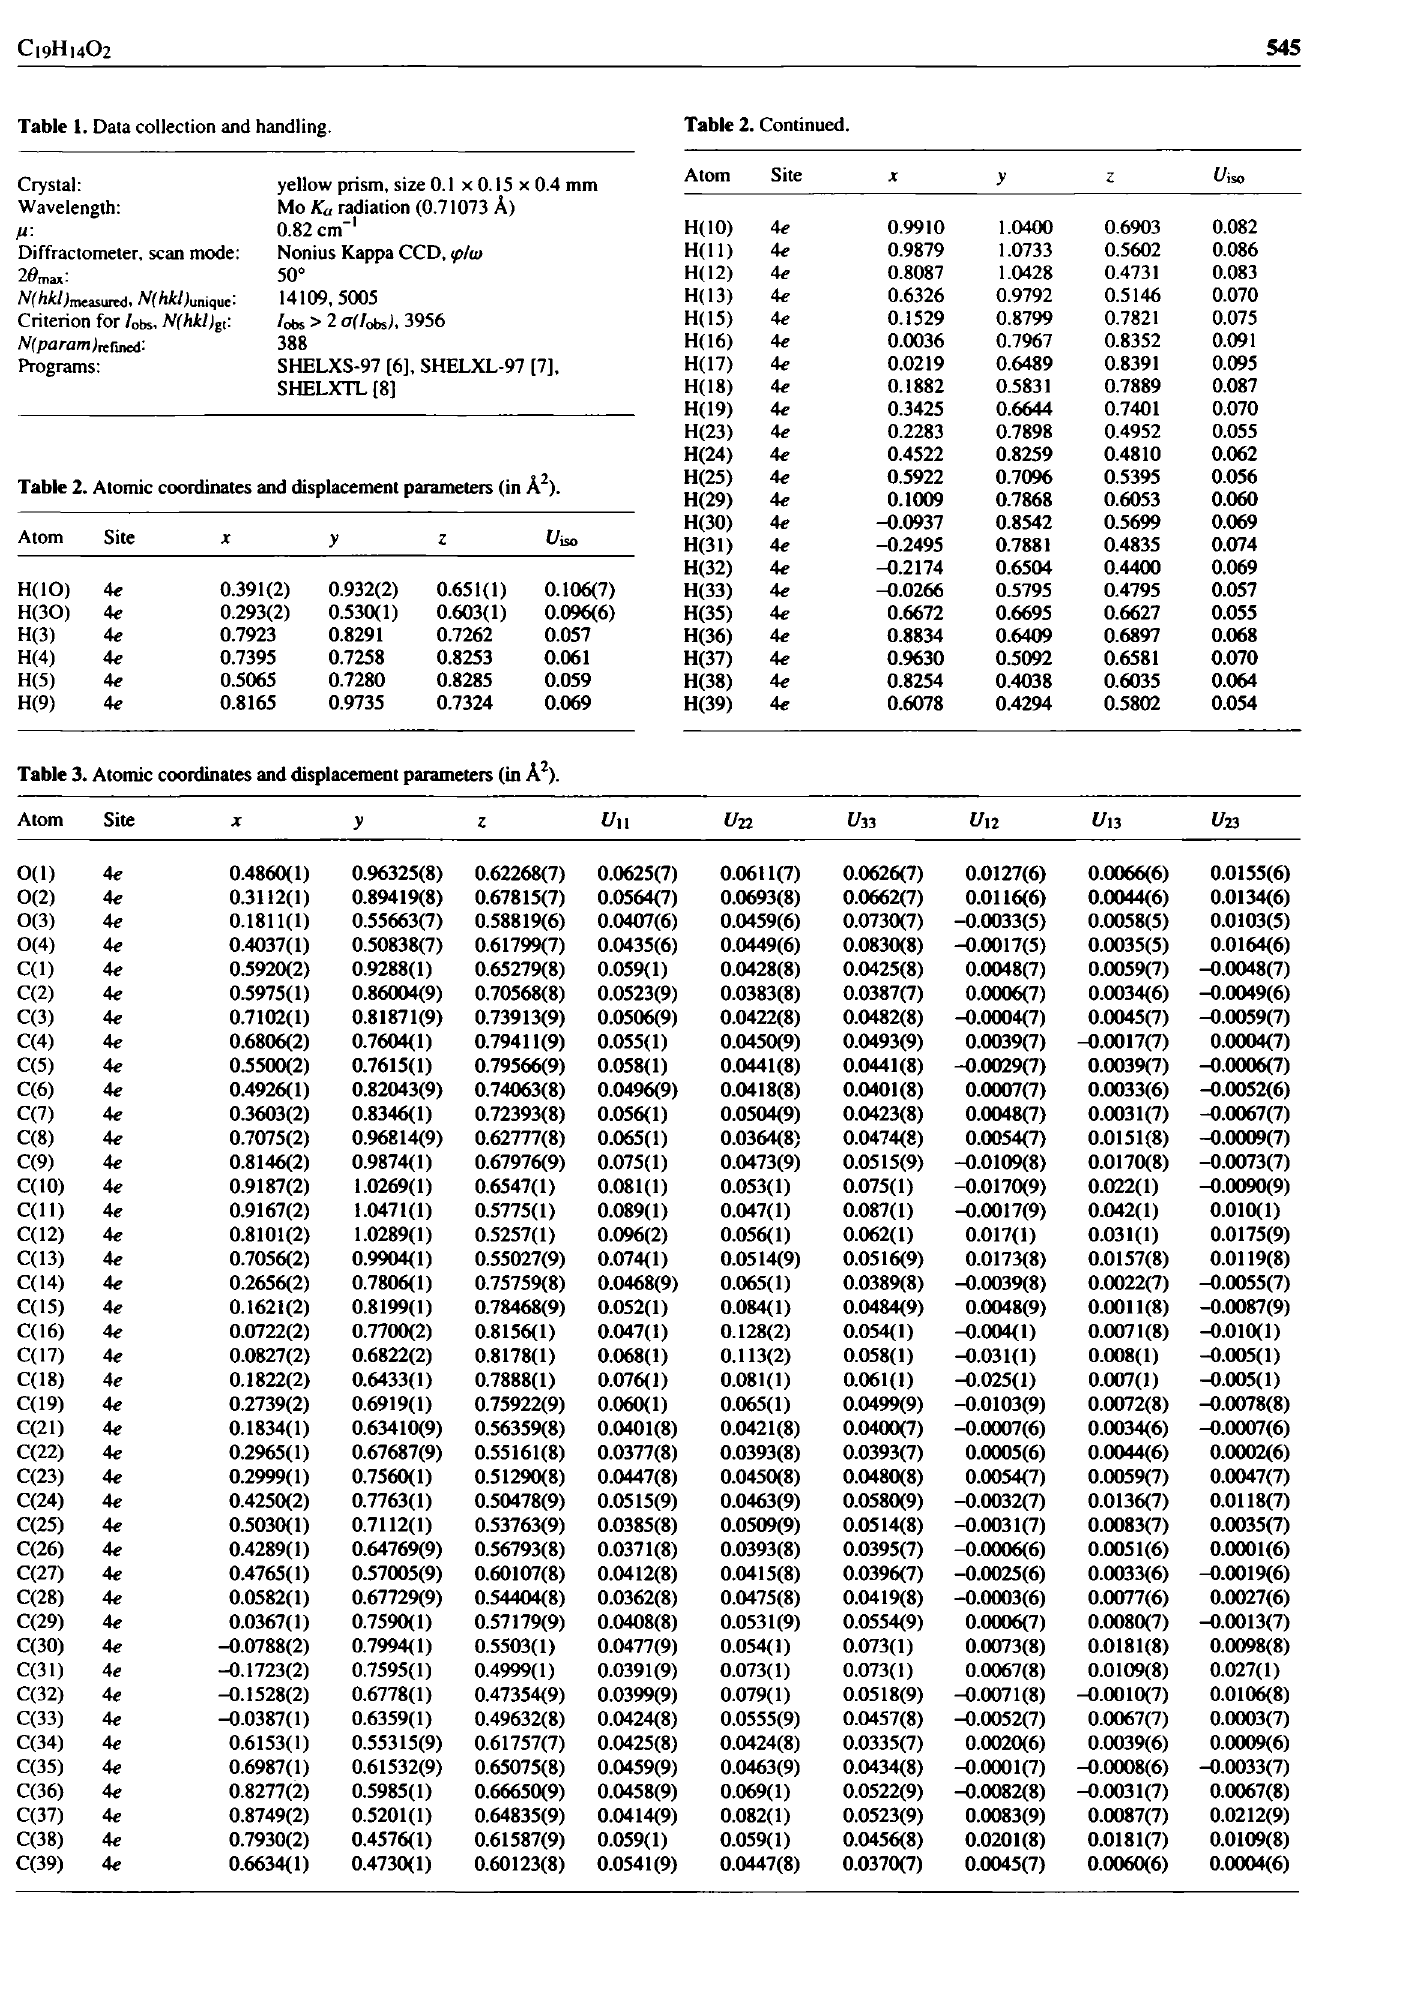
Table 2. Atomic coordinates and displacement parameters (in Â 2 ).